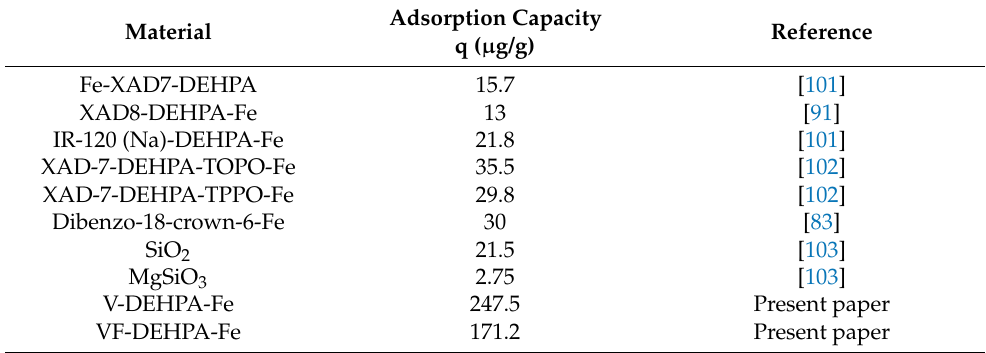
Table 5. Comparison between adsorption capacities obtained for different adsorbent